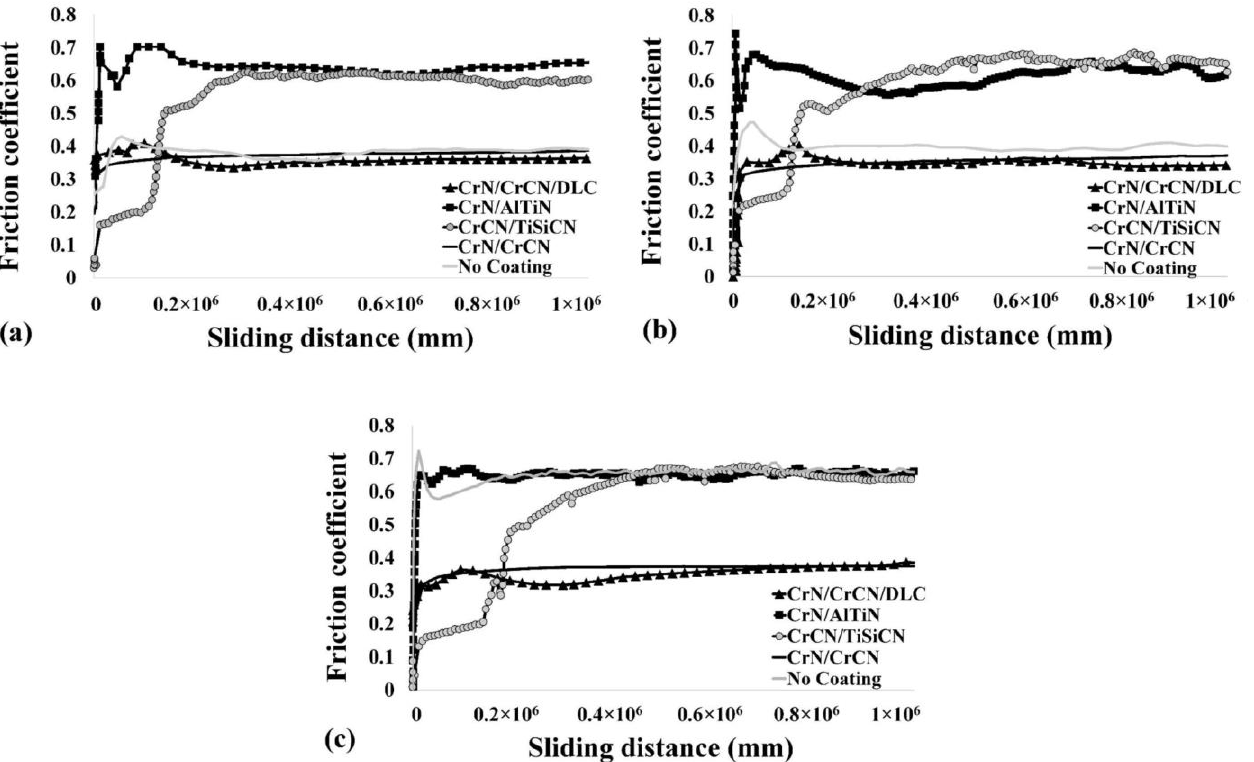
Figure 14. Variation of friction coefficient in terms of sliding distance at sliding speed of ( a ) 50 mm/s, ( b ) 100 mm/s, and ( c ) 250 mm/s.